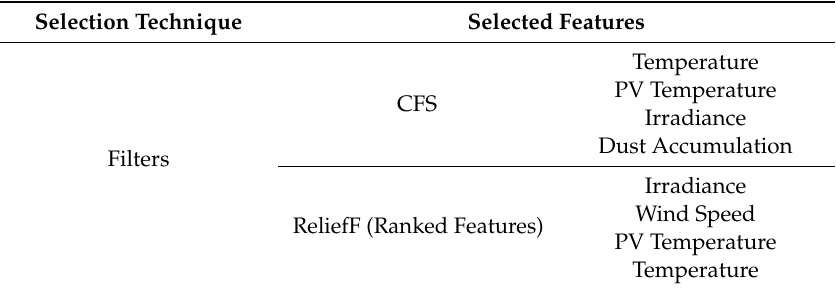
Table 5. Selected features vector.